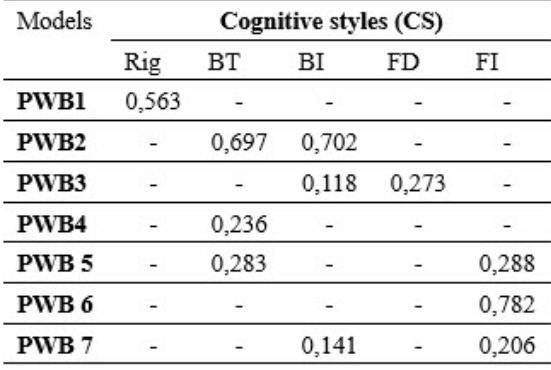
Table 1. Style predictors